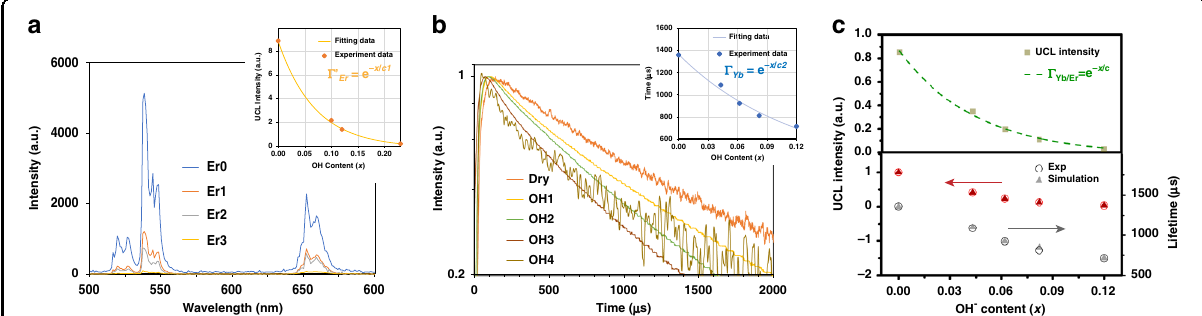
Fig. 2 Linear and nonlnear luminescence and relevant simulation results. a UCL spectra of NaYF 4- x (OH) x :2%Er@NaYF 4 nanoparticles with variable OH − contents in the core ( x : 0 – 0.23). Inset shows the corresponding UCL emission intensity (integrated from 500 to 700 nm), which can be well fi tted by Eq. (2). b Luminescence decay curves of the 2 F 5/2 → 2 F 7/2 transition of Yb 3 + in co-doped NaYF 4- x (OH) x :Yb/Er@NaYF 4 nanoparticles (Ex: 980 nm, Em: 1020 nm). Inset shows internal OH − content-dependent decay lifetime, which can be well fi tted by Eq. (3). c Top: internal OH − content-dependent UCL intensity (integrated from 500 to 700 nm) of NaYF 4- x (OH) x :Yb/Er@NaYF 4 nanoparticles. Green dots are the experimental values and the curve is the calculated result from Eq. (4); bottom: comparison of experimental (circle) and simulation (triangle, R Yb-OH = 2100 s − 1 ) results for the Yb 3 + decay lifetimes (black color) and UCL intensities (red color) of NaYF 4- x (OH) x :Yb/Er@NaYF 4 core/shell